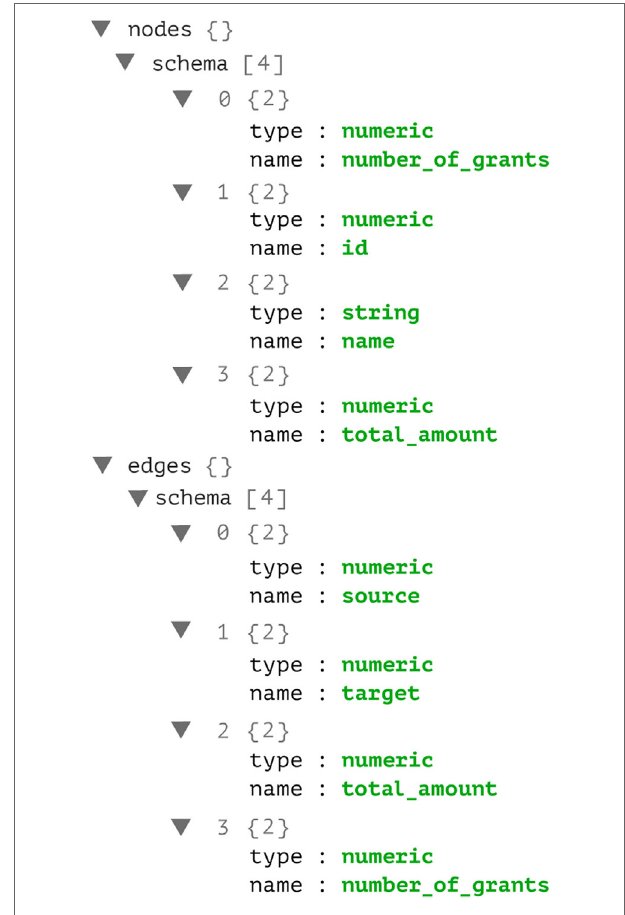
FigUre 4 | JSON data schema for the Co-PI Collaboration Network visualization plugin.